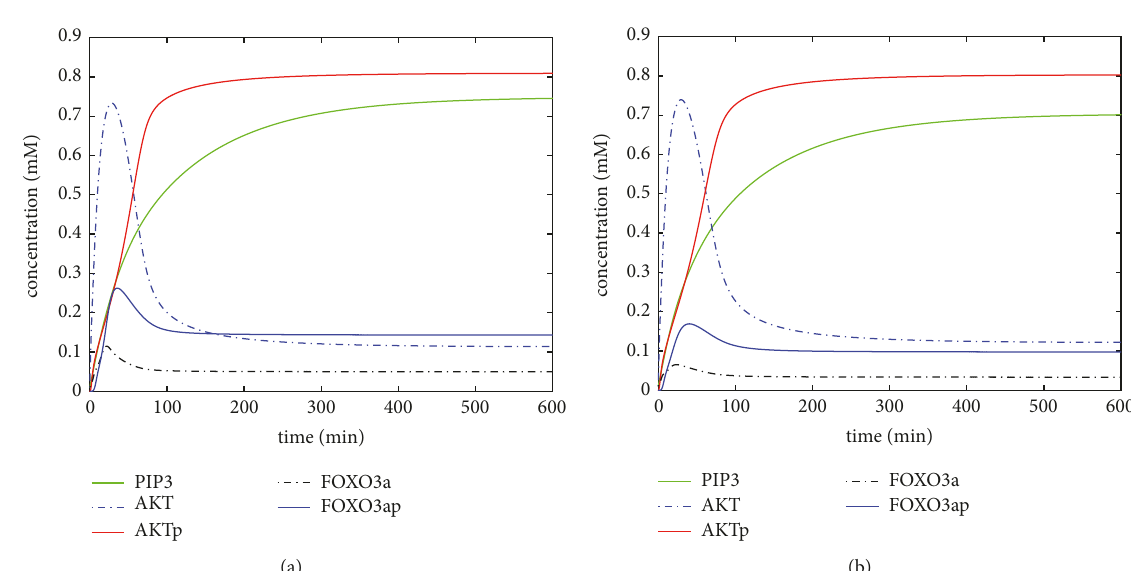
Figure 7: Dynamics of PIP3, AKT, AKTp, FOXO3a, and FOXO3ap in the AML cell with increasing rate of FOXO3a phosphorylation from 1.0 (a) to 2.0